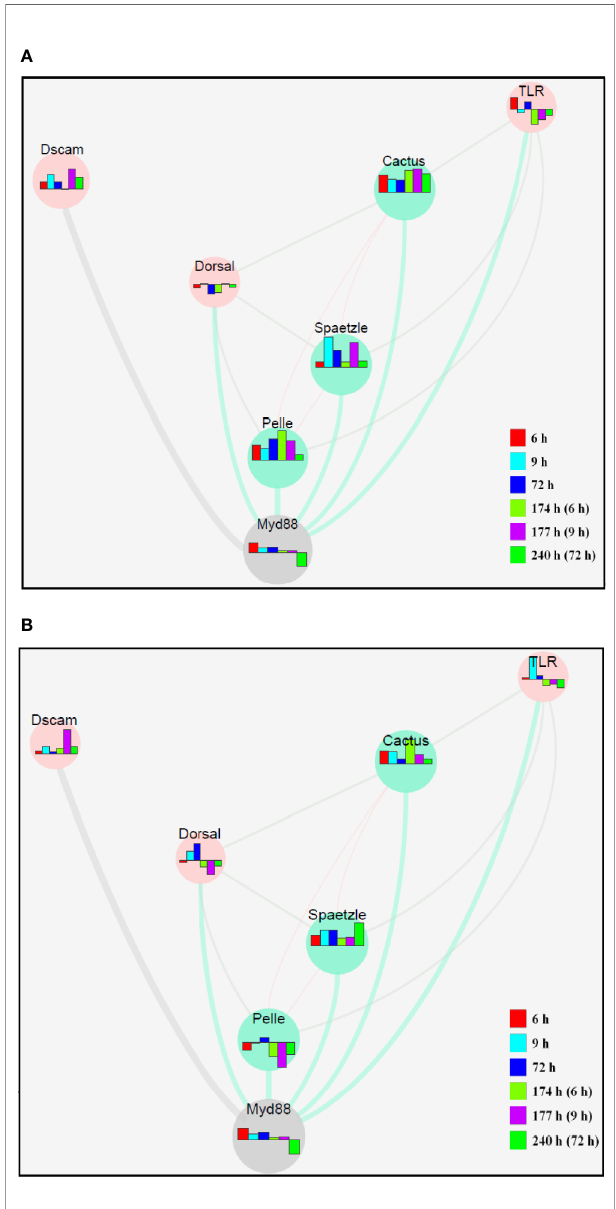
FIGURE 5 | The molecular network of related genes in the TLR signaling pathway in response to secondary challenge by V. parahaemolyticus in the hepatopancreas (A) and hemocytes (B) of S. paramamosain constructed by Cytoscape. The bar chart represents the different expression patterns of each gene, and the different colors of the bar chart represent different time